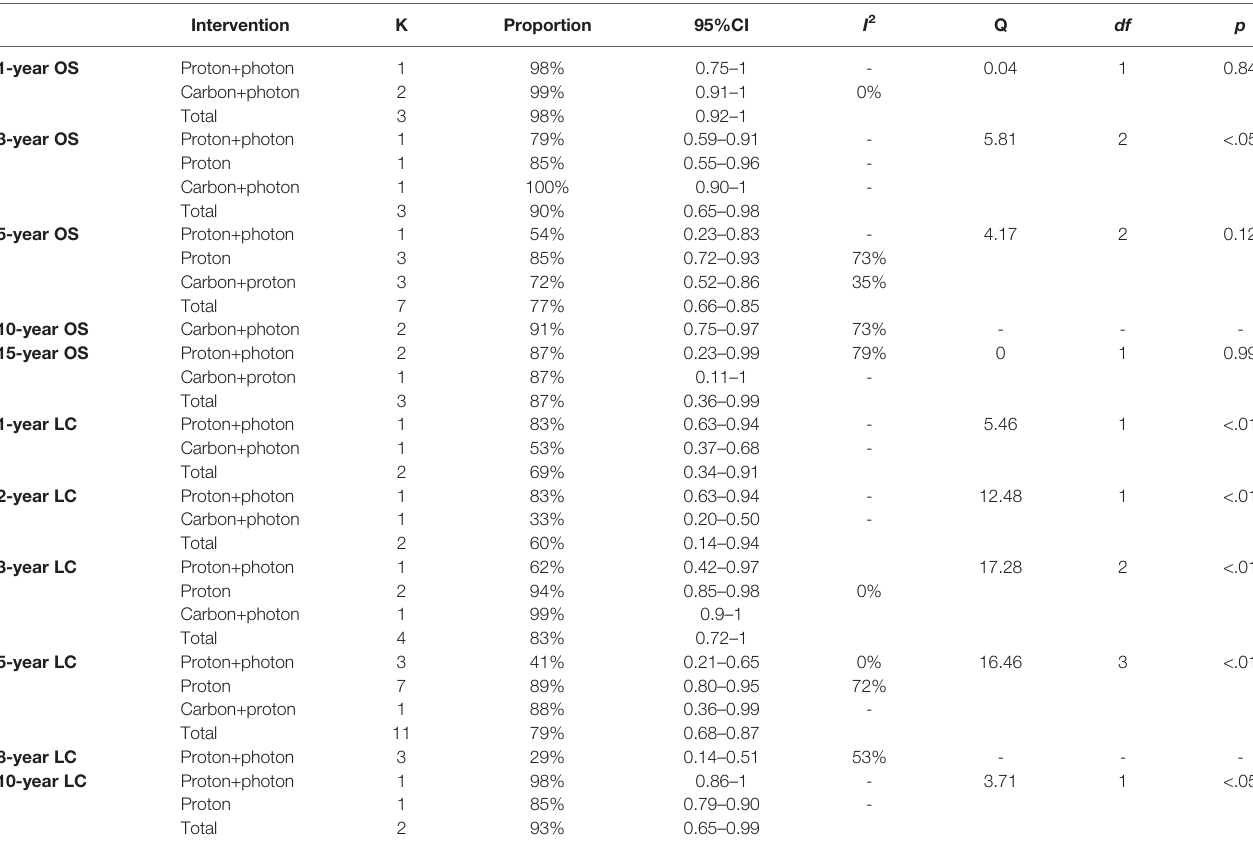
TABLE 2 | Outcomes with various treatment methods for meningioma. Intervention